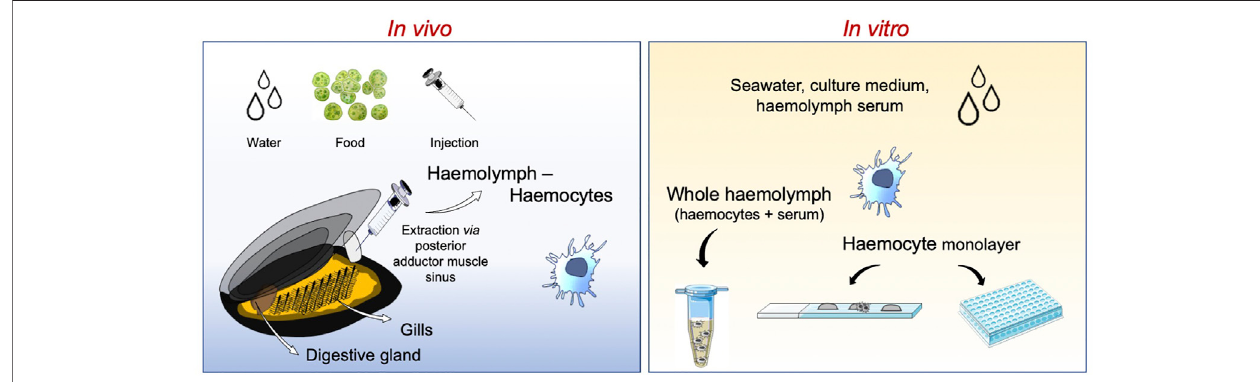
FIGURE 1 | Schematic representation of experimental immune assessments using the mussel Mytilus galloprovincialis. Studies can be performed at the whole animal level with in vivo experiments or on isolated haemocytes and haemolymph with in vitro assays.